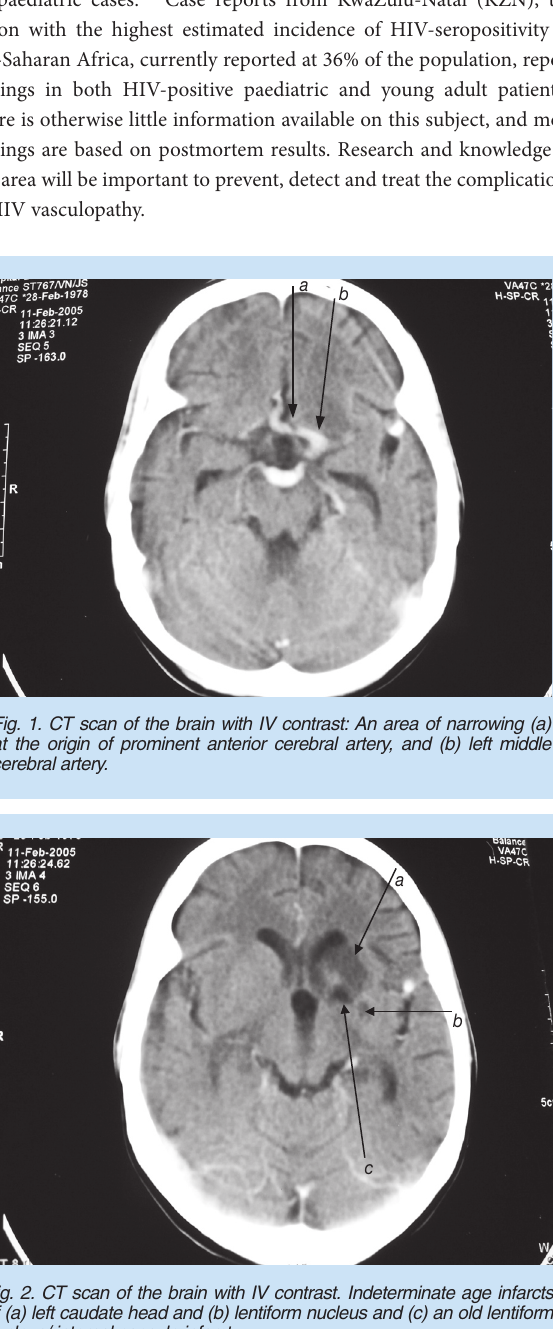
Fig. 3. MRI scan of the brain, FLAIR sequence, showing high signal intensity foci (arrows) corresponding to the CT